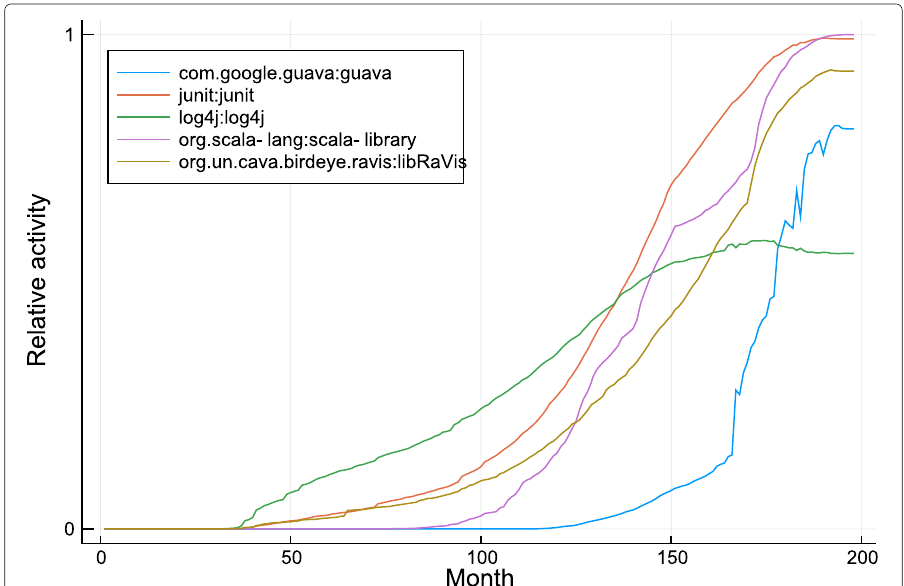
Fig. 19 Maven degree distributions. In and out degree distributions for the Maven package